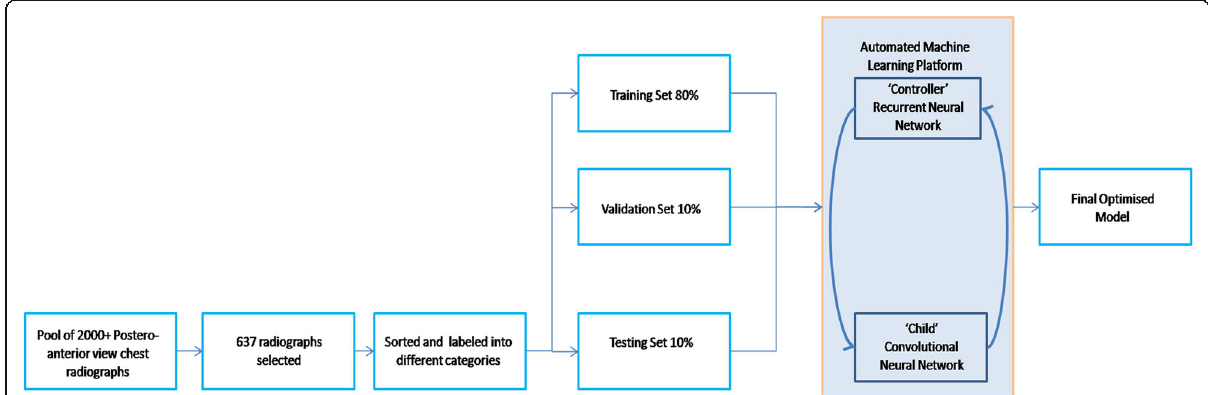
Fig. 1 Flowchart summarizing the data categorization and model development process